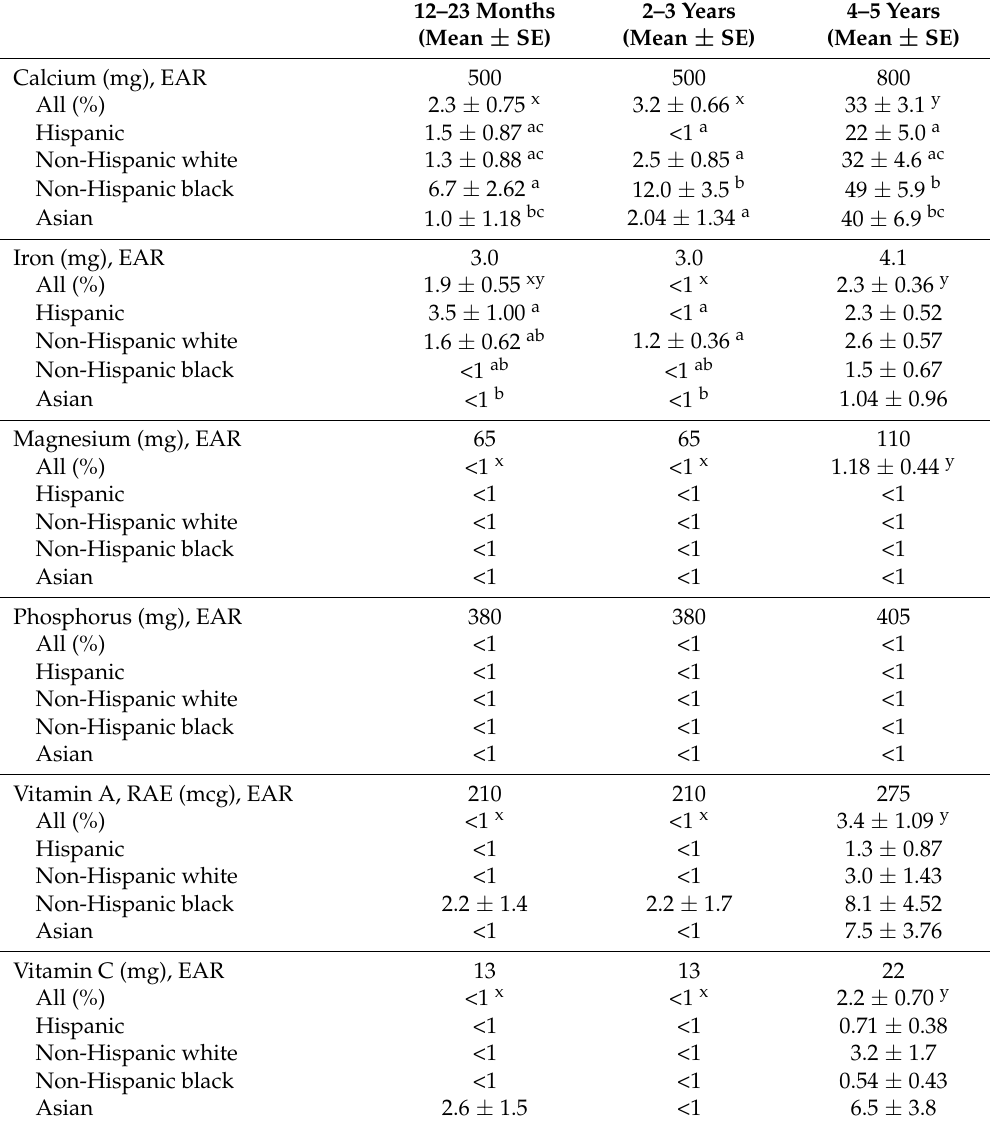
Table 6. Percent of children below the Estimated Average Requirement (EAR) by age and ethnicity, NHANES